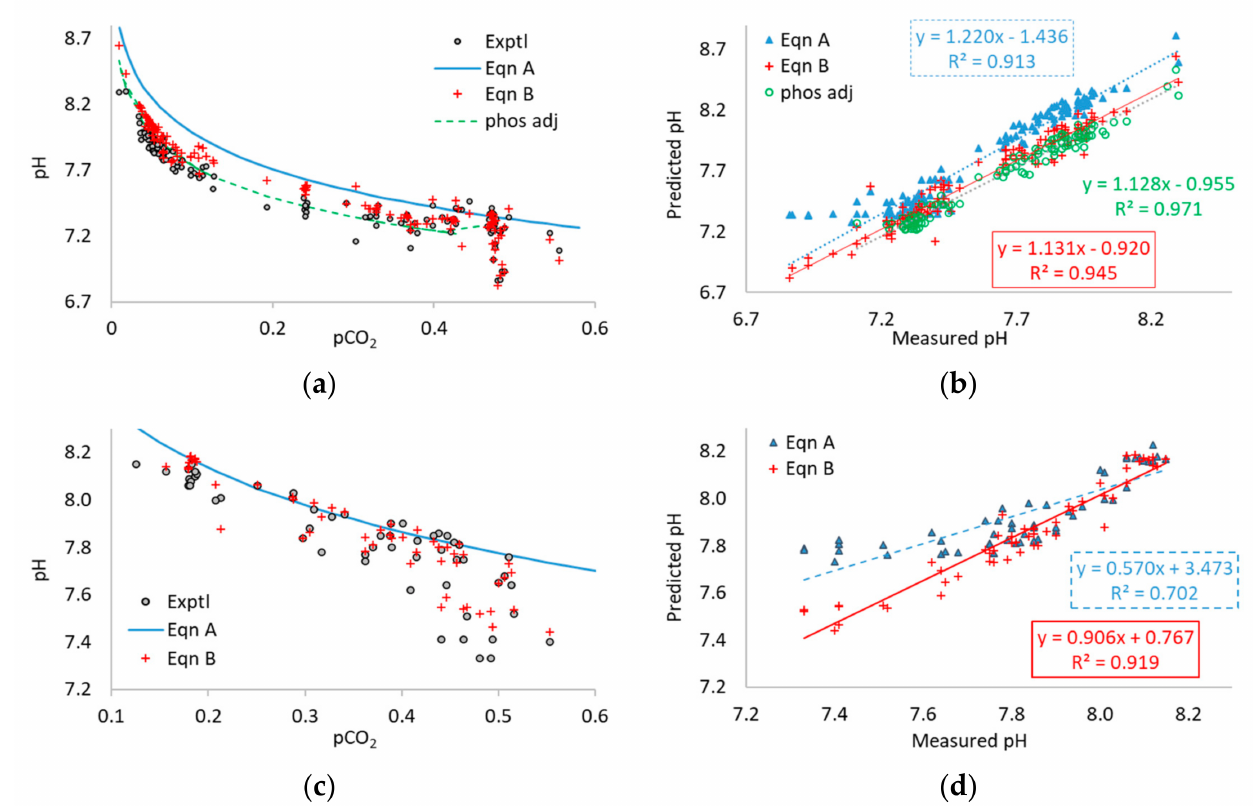
Figure 2. Experimental pCO 2 and pH values and predicted pH from Equations A and B for mesophilic CO 2 biomethanisation of phosphate-containing synthetic feed at OLR 3 g COD L − 1 day − 1 ( a , b ) as